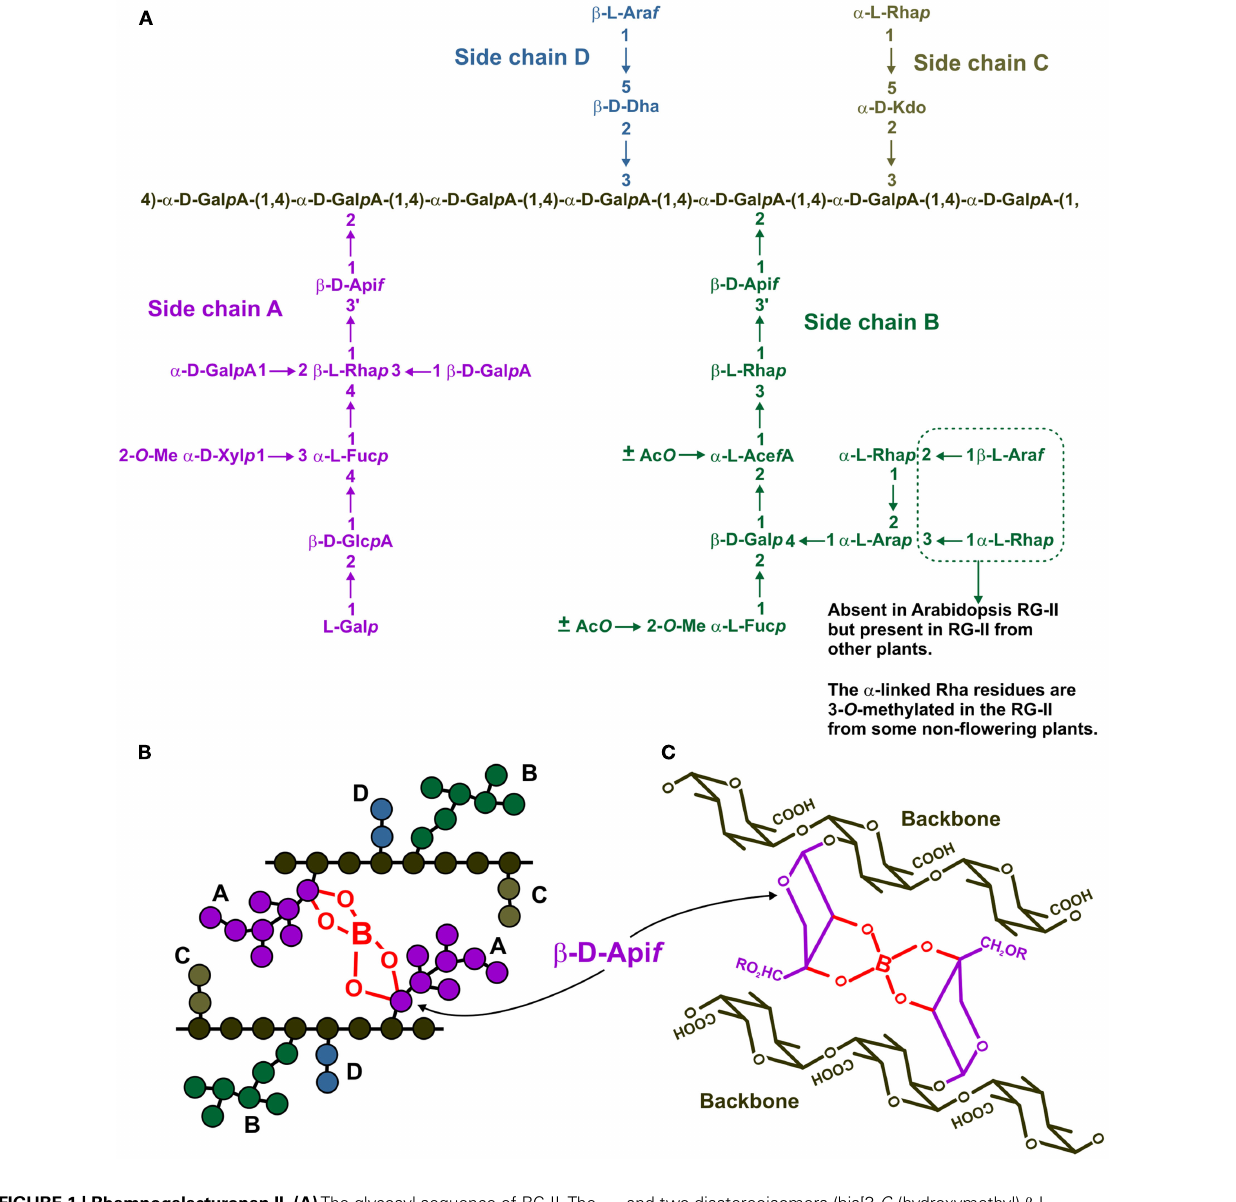
FIGURE 1 | Rhamnogalacturonan II. (A) The glycosyl sequence of RG-II.The nominal mass for the RG-II monomer is 4,612, assuming a backbone of 7 GalA residues and fully decorated side chains. (B) Cartoon showing the cross-linking of two RG-II molecules. (C) The borate diester cross-link.When two apiosyl residues are linked by a borate diester, the boron atom is chiral,